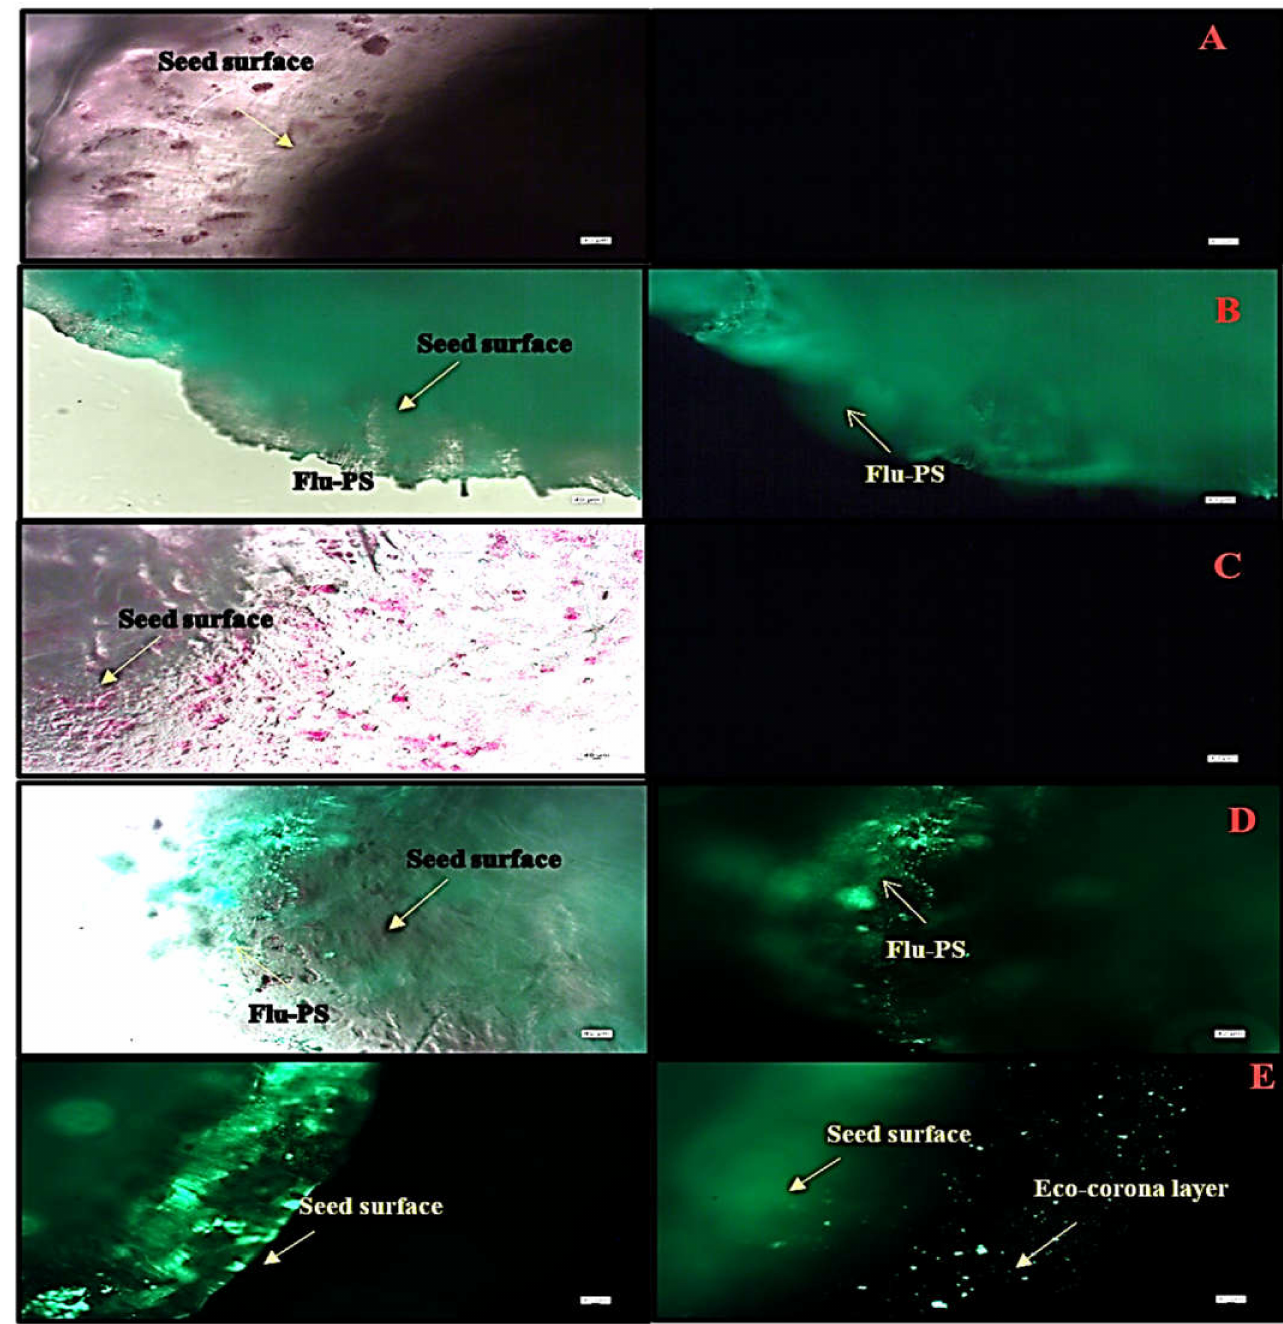
Figure 5. Fluorescence microscopic image of ( A ) the control, ( B ) Flu − PS, ( C ) HA, ( D ) Flu − PS+HA, and ( E ) Flu − PS+HA on Solanum lycopersicum seeds. ( B ) Flu − PS interacted with seeds after 24 h; the microscopic image shows a lesser number of healthy cells on the surface of the seed. ( A ) The control and ( C ) HA microscopic image shows a higher number of healthy cells on the surface of the seed and ( D ) the Flu − PS+HA microscopic image shows evidence of a higher number of healthy cells; on the surface of the seed, an eco-corona layer was